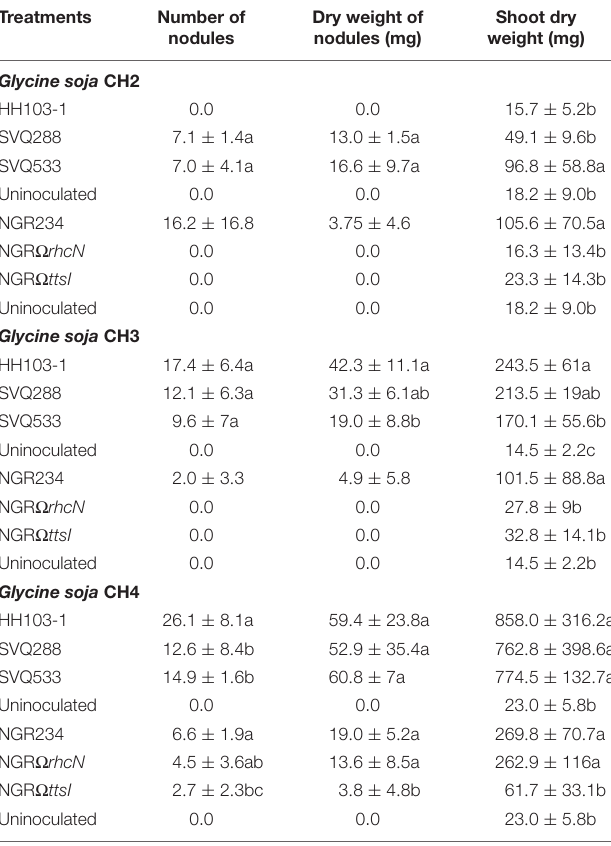
Type Three Secretion System